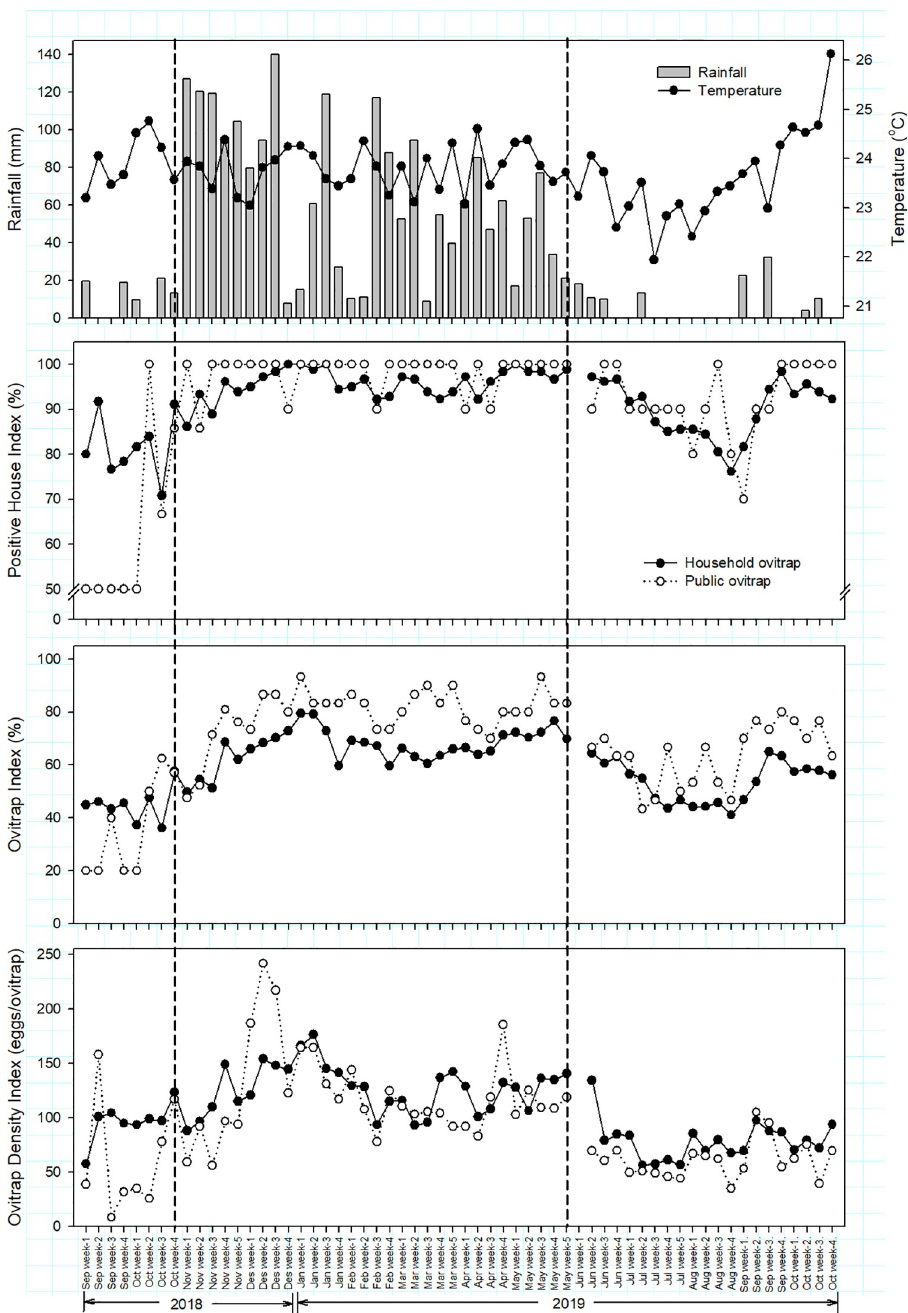
Fig 2. Aedes vector indices of ovitraps installed at households and public places in Sekejati urban village, Bandung, from September 2018 to October 2019. The cumulative rainfall of the wet season was calculated from the 4th week of October 2018 to the 5th week of May